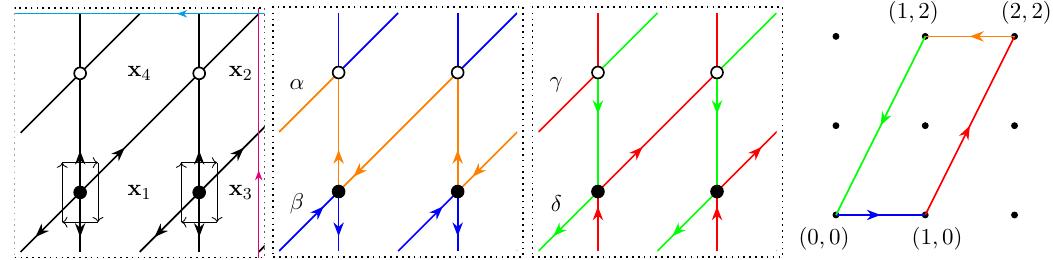
Figure 13 . Left: bipartite graph for the two-particle Toda chain, small arrows give the Poisson structure from (cid:12)gure 17. Center: zig-zag paths (cid:11); (cid:12); (cid:13); (cid:14) . Right: Newton polygon obtained from zig-zags as elements H 1 ( T 2 ; Z ). Numbers are labeling degrees of ( (cid:21); (cid:22) ) in spectral curve (B.13). Zig-zag variables x always present non-trivial elements from H z i itself cannot be expressed via the cluster variables. On the central and right pictures from (cid:12)gure 13 zig-zag paths for the Toda chain on two sites are drawn. Casimir Z from the example from previous sub-section in terms of it is given by Z = x Spectral